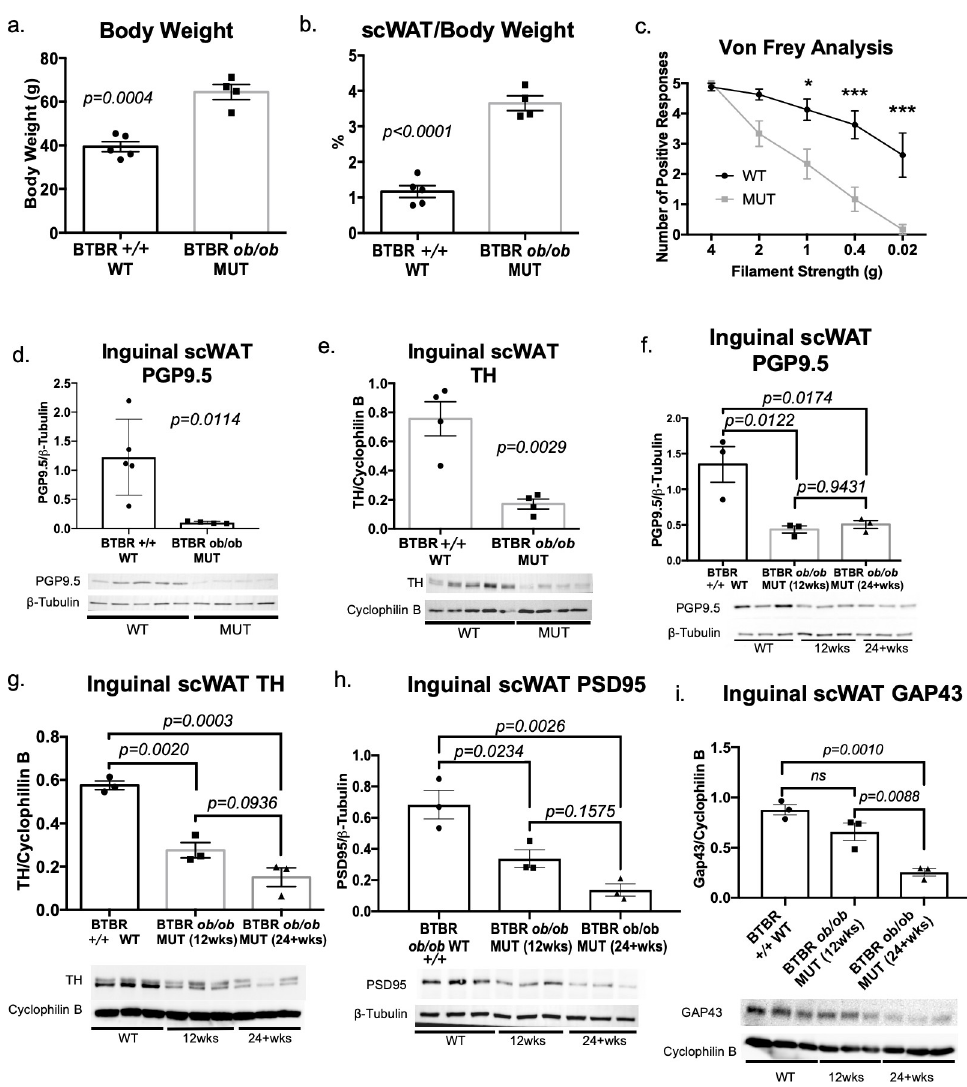
Fig 1. Obesity and diabetes led to white adipose tissue neuropathy. The BTBR ob/ob (MUT) model of obesity and diabetes was compared to BTBR +/+ wild-type (WT) for body weight measurements (a), and adiposity (b). Body and tissue weight data were analyzed by two-tailed Student’s t-test. Von Frey tactile allodynia analysis was performed on MUT and WT animals to determine onset of peripheral neuropathy (c). Von Frey data was analyzed by ANOVA with Sidak’s post hoc test. For (a-c), all males; WT N = 8, 12–20 weeks old; MUT N = 6, 12–24 weeks old. Protein levels of PGP9.5 (d), as well as TH (e) in inguinal scWAT of the MUT and WT mice were measured by western blotting. For (e), lane 5 was excluded from analyses due to uneven resolution of housekeeper. For (d-e), all males; WT N = 5, 12–20 weeks old and MUT N = 4, 12–20 weeks old. Protein expression of PGP9.5 (f), TH (g), PSD95 (h), and GAP43 (i) in inguinal scWAT of 12–25 weeks old WT, 12 week old MUT and 24–28 week old MUT was measured by western blotting. All males, N = 3 per group. Western blot data were normalized to either β -Tubulin or Cyclophilin B, band intensity were quantified in Image J, and analyzed by two-tailed Student’s t-test. Error bars are